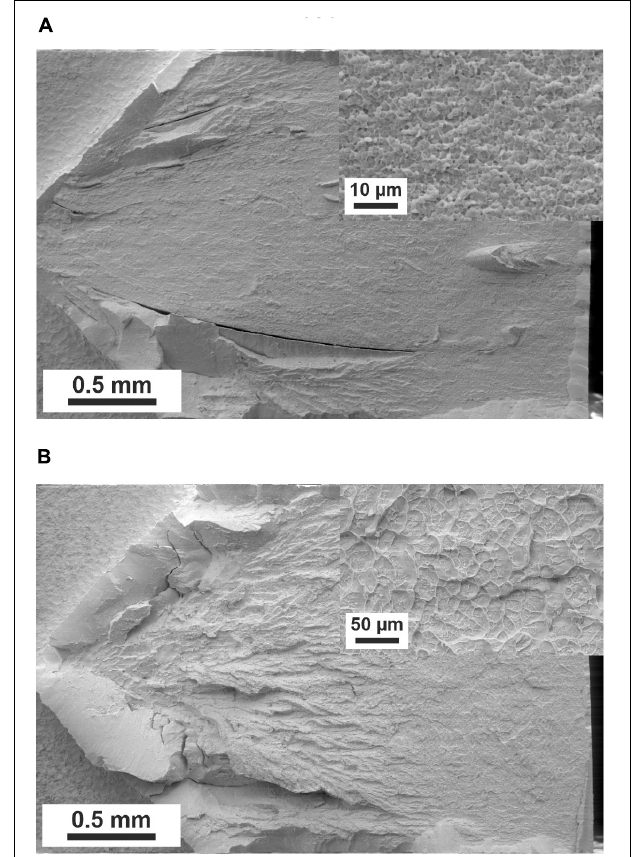
FIGURE 5 | (A) Scanning electron microscopy (SEM) fracture surface images of the samples corresponding to the stress deflection curve in Figure 4A fracture surface of sample type A, (B) fracture surface of sample type